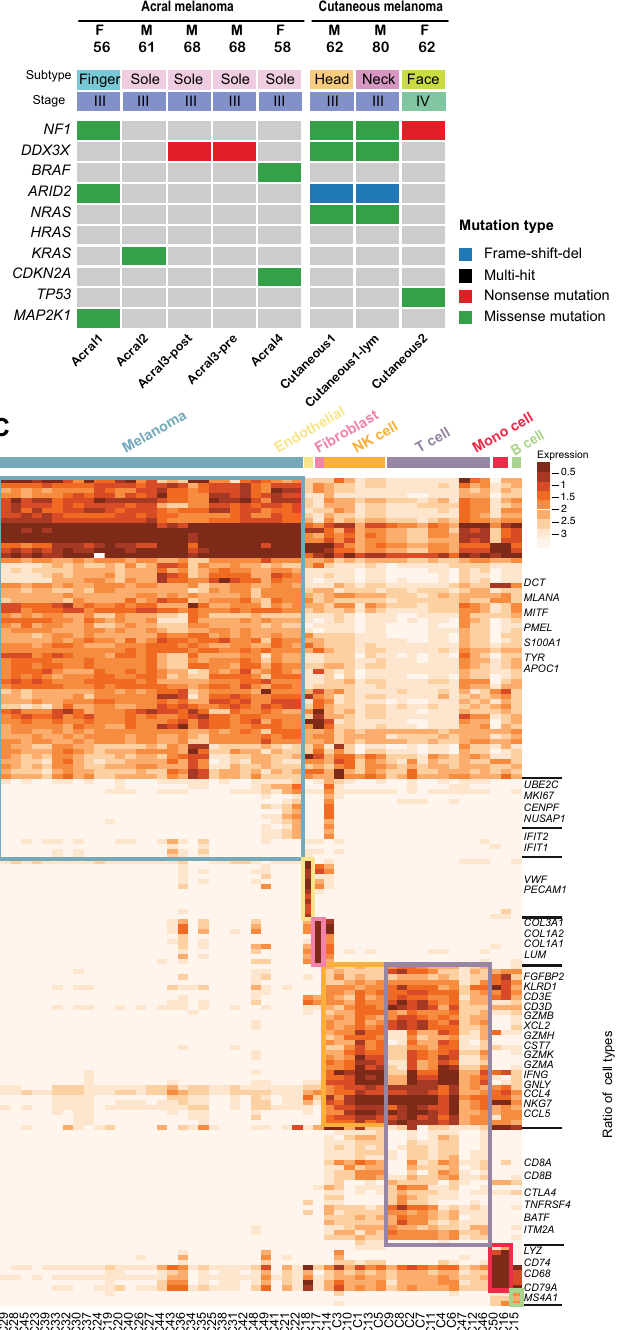
panel), and AM or CM origin (right panel). (Mono, Monocyte) C Heatmap showing the expression of marker genes in the 50 cell clusters. The top bars label the clusters corresponding to speci fi c cell types. D Histogram indicating the propor- tion of cells in tumor tissue of each analyzed patient. Non-immune cells and immune cells are shown in separate histograms. (Mono,